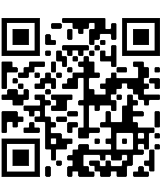
Figure 10 . QR code to get access to the virtual visualization of the gigapixel image using any mobile device.